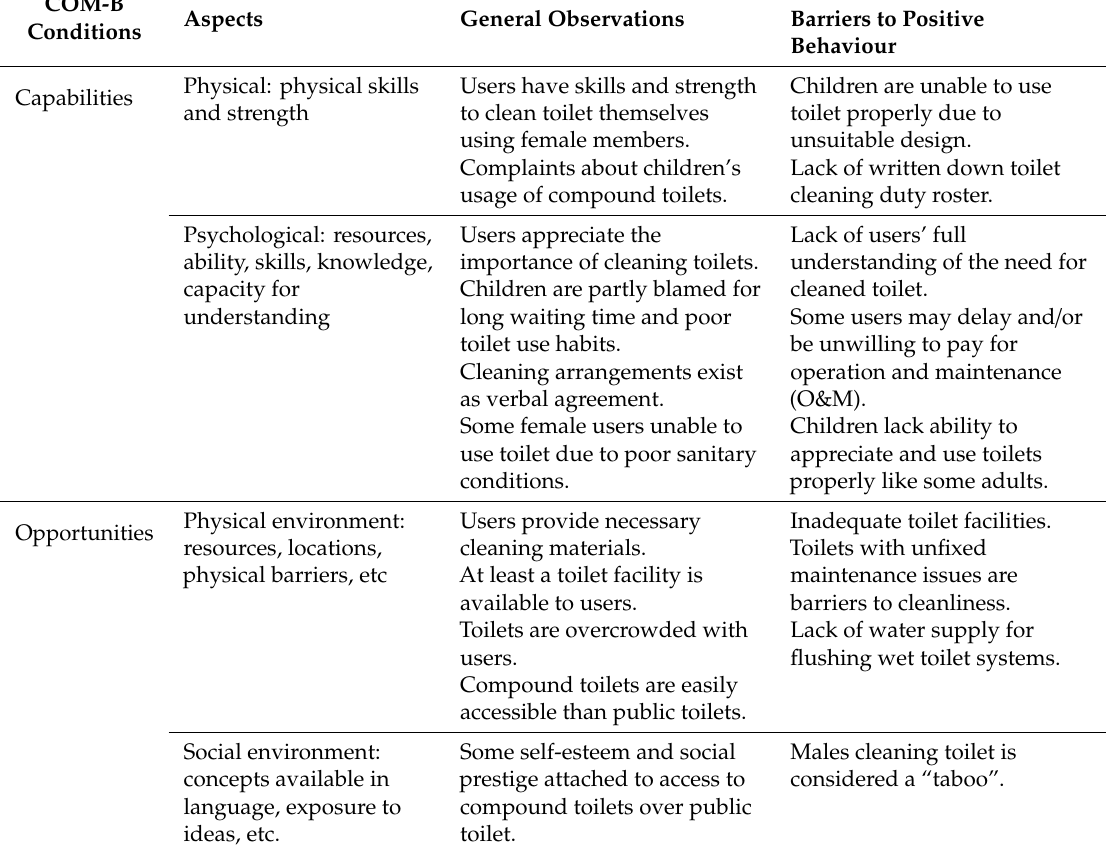
Table 3. Analyses of emerging behaviour patterns using the COM-B system of the Behaviour Change Wheel